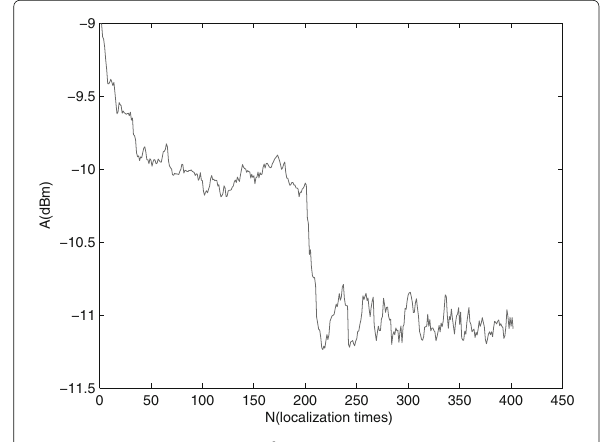
Fig. 8 Convergence process of